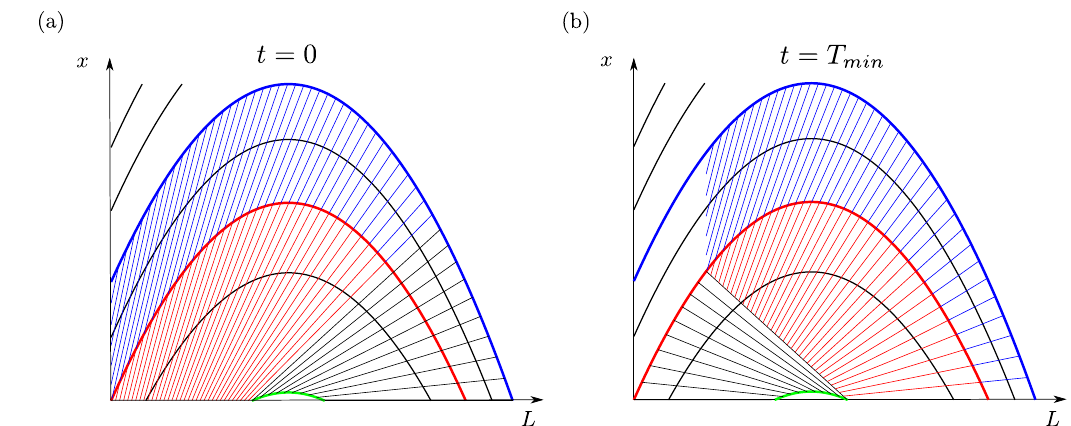
Figure 4. Solution of the linear model by stepping forward in time with a stepsize equal to the minimum residence time T min . The diagram ( a ) on the left-hand side shows, in addition to the characteristics, straight lines connecting crystals that will arrive in the mill at the same time. Diagram ( b ) on the right-hand side shows the position that the crystals on the straight lines have reached after a time interval of length T min